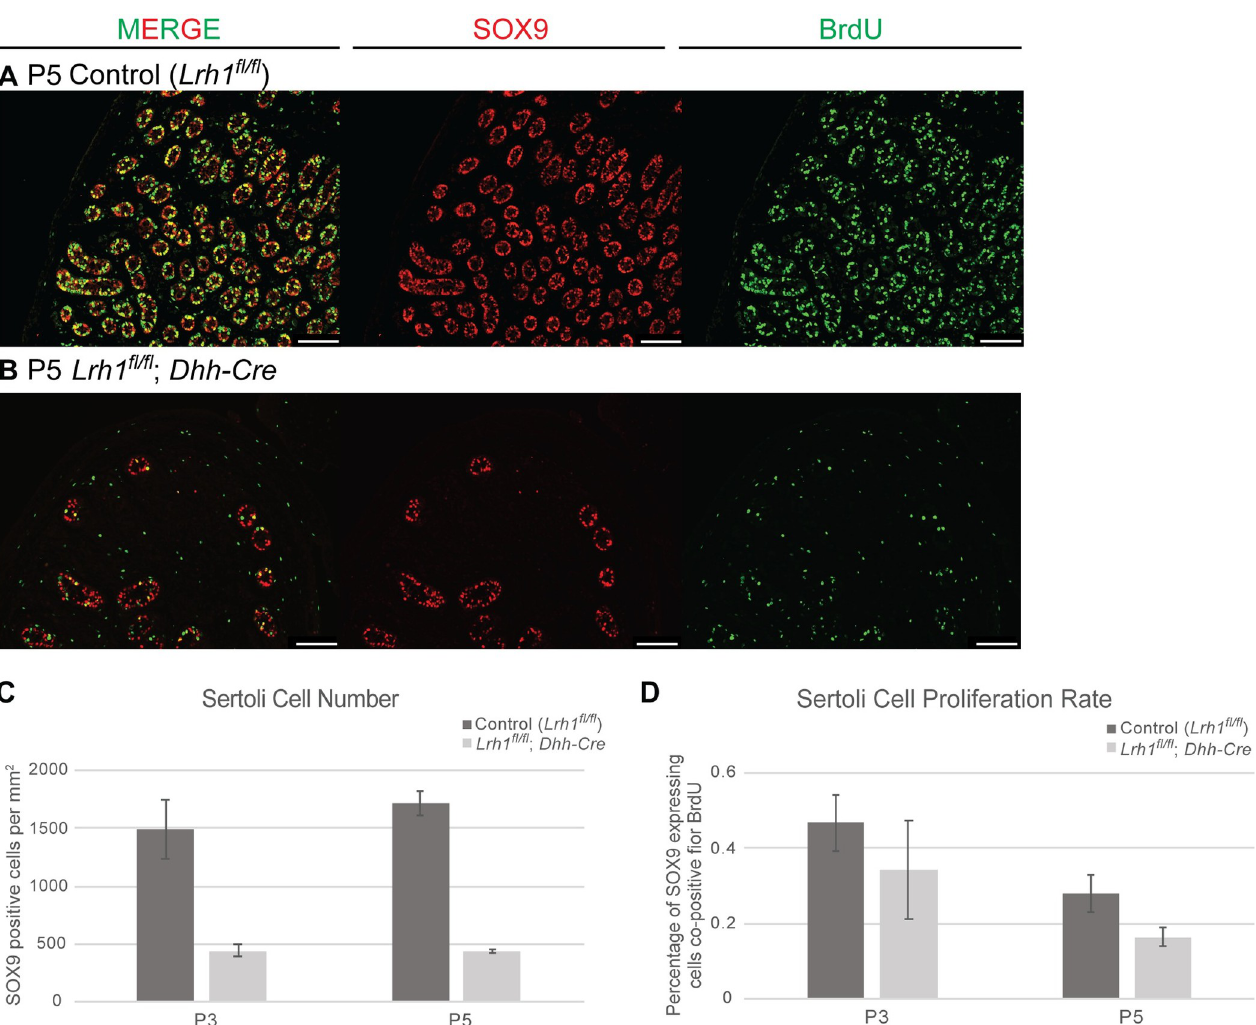
Fig 7. Fetal loss of Lrh1 causes reduced perinatal Sertoli cell proliferation (A,B) IF of P5 control and conditional Lrh1 mutant testes deleted with Dhh-Cre and stained for SOX9 (red), BrdU (green) and DAPI (blue). (C) Plot of SOX9-positive Sertoli cells per mm 2 at P3 and P5 in control and Dhh-Cre deleted Lrh1 conditional mutant testes. (D) Plot of BrdU-positive SOX9-expressing Sertoli cells in the same testes at P3 and P5. Error bars: standard error of mean (SEM). Scale bars: 100 um.